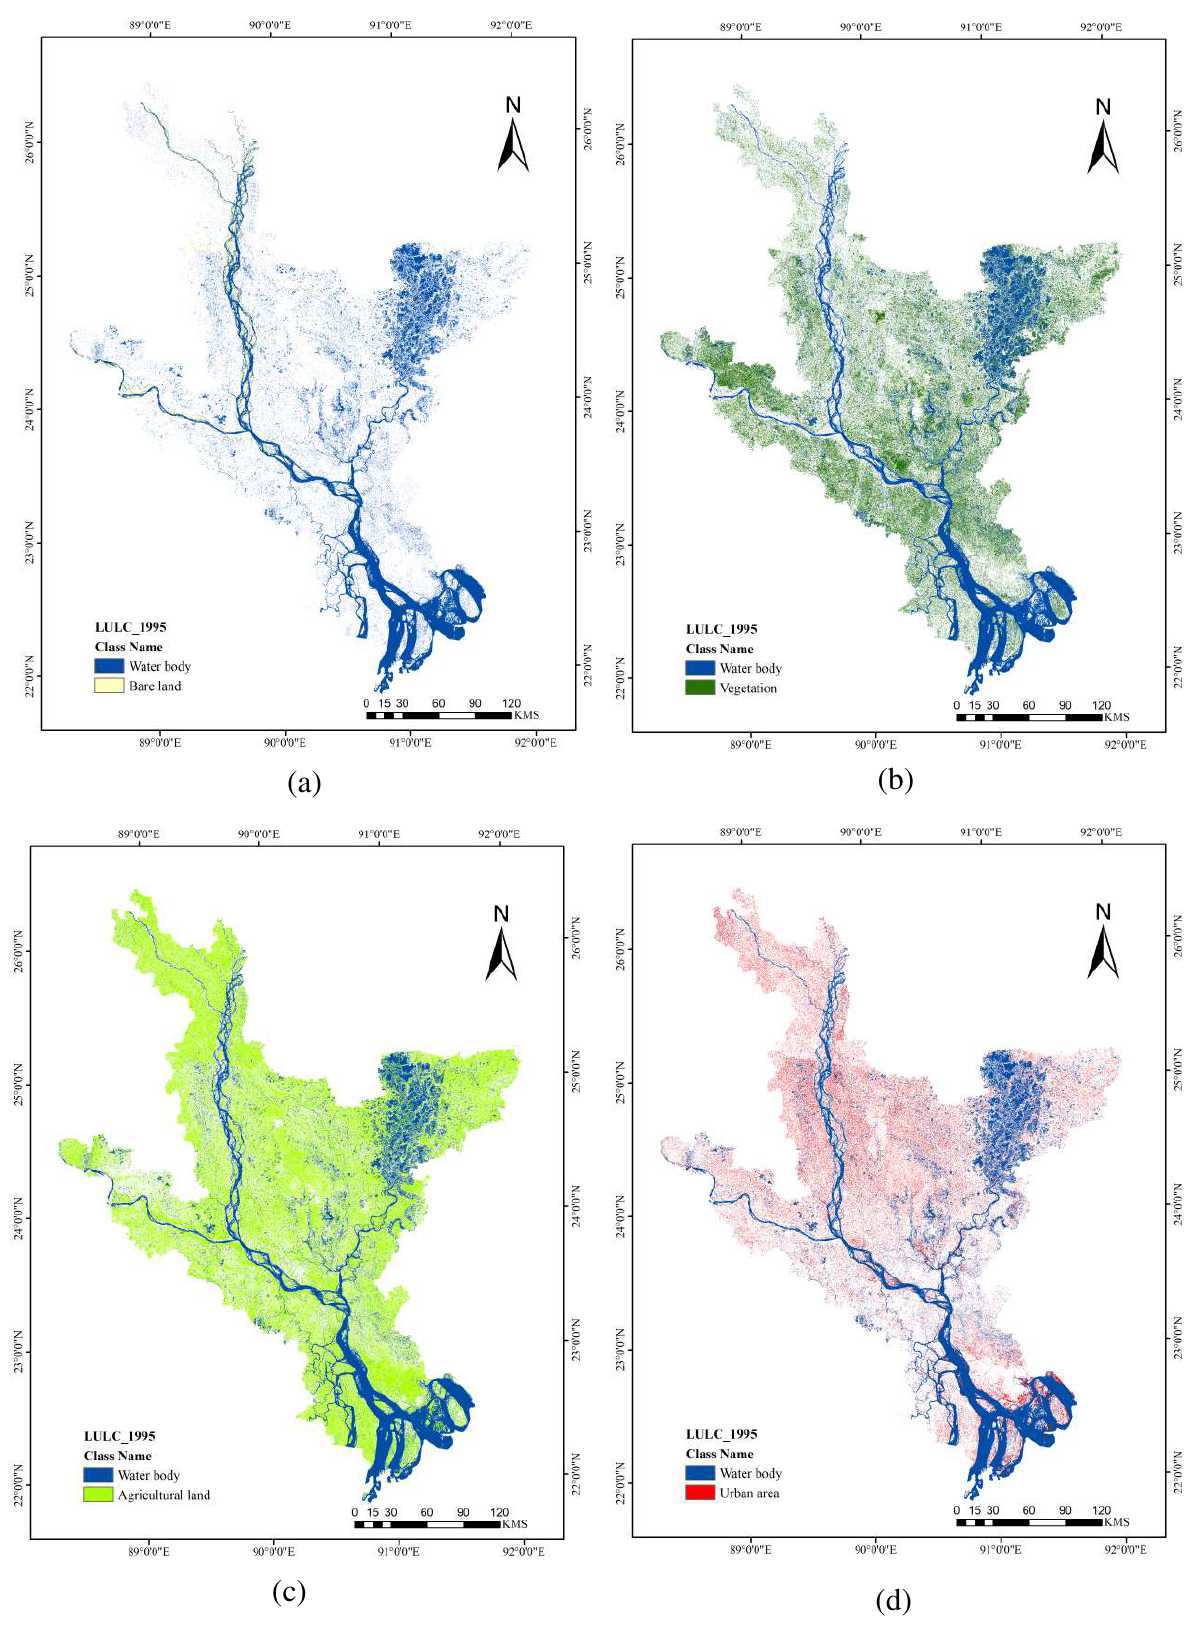
Figure 4. LULC map for different classes with permanent water bodies; ( a ) bare land; ( b ) vegetation; ( c ) agricultural land and ( d ) urban area in 1995.